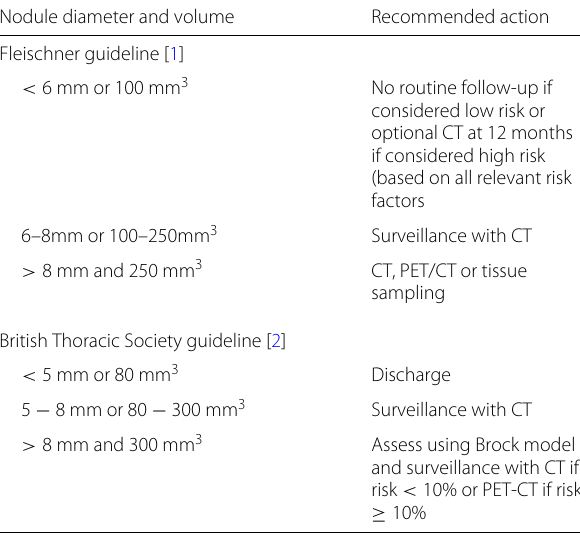
Table 1 Abridged guideline recommendations following detection of incidentally detected lung nodules Nodule diameter and volume Recommended